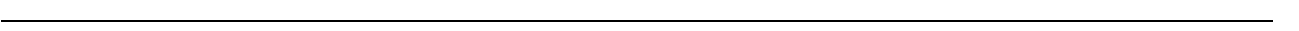
Fig. 1 NUDT5 is a key regulator of ADP-ribose metabolism. a Hydrolysis of potential oxidized nucleotides and nucleotide-sugar substrates by MTH1 (blue) and NUDT5 (red), as measured by the enzyme-coupled malachite green assay (MG assay), at pH 7.5. A representative experiment (of n = 2) with mean ± SD and individual values of quadruplicate replicates is shown. b Representative HPLC traces of NUDT5-mediated ADPR (red) and 8-oxo-dGDP (blue) hydrolysis to AMP or 8-oxo-dGMP, respectively ( n = 2). c Top: Representative, pseudo-colored immuno fl uorescence stainings for γ H2A.X, chromatin- bound RPA, and 53BP1 in U-2 OS cells following treatment with negative control siRNA (siNeg) or NUDT5 siRNA (siNUDT5 #1, siNUDT5 #7) for 72 h. Scale bar = 20 µ m. Bottom: Quanti fi cation of γ H2A.X, chromatin-bound RPA, and 53BP1 staining intensity in cells representing three independent experiments (cells scored: γ H2A.X, n = 871; RPA, n = 463; 53BP1, n = 981). Lines represent median fl uorescence (and interquartile range for 53BP1); a.u. arbitrary units. NS not signi fi cant, *** p < 0.001, **** p < 0.0001; Kruskal-Wallis test). d Top: Representative, pseudo-colored images of treated U-2 OS cells following the modi fi ed alkaline comet assay and con fi rmation of NUDT5 knockdown with a cropped western blot. Scale bar = 50 µ m. Bottom: Quanti fi cation of the tail moment (relative to the DMSO+siNeg, buffer-treated control) from two independent experiments performed in duplicate (minimum of 100 cells per slide per condition). Buffer-treated samples are shown in blue, OGG1-treated samples in red. Lines represent median tail moments. **** p < 0.0001 by Kruskal – Wallis test comparing OGG1-treated samples. e A graphical procedure depicting the analysis of ADPR hydrolysis in cell lysates by HPLC. f ADP-ribose hydrolysis in U-2 OS cells alone (black, solid and dotted), following depletion with two different NUDT5 siRNAs (blue, solid and dotted) or siRNA-treated cells complemented with puri fi ed NUDT5 protein (red, solid and dotted), as quanti fi ed by HPLC. A representative chromatogram is shown (of n = 2 independent experiments) and NUDT5 knockdown con fi rmation with cropped western